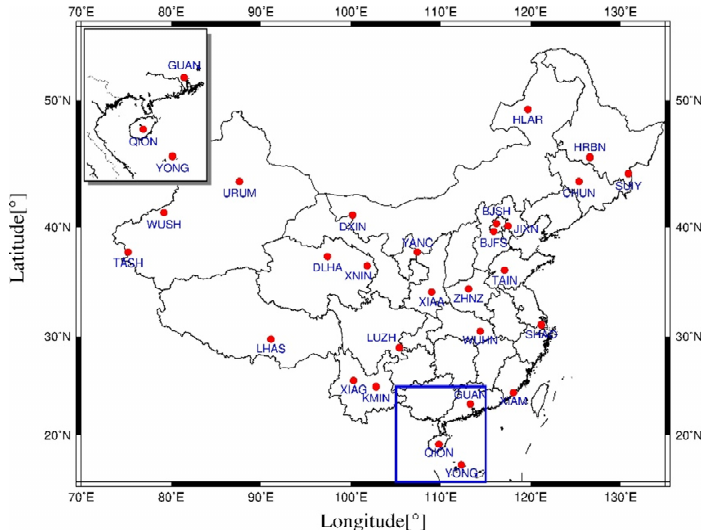
Figure 3. Geographic locations of 27 stations in the Crustal Movement Observation Network of China (CMONOC) [58] .